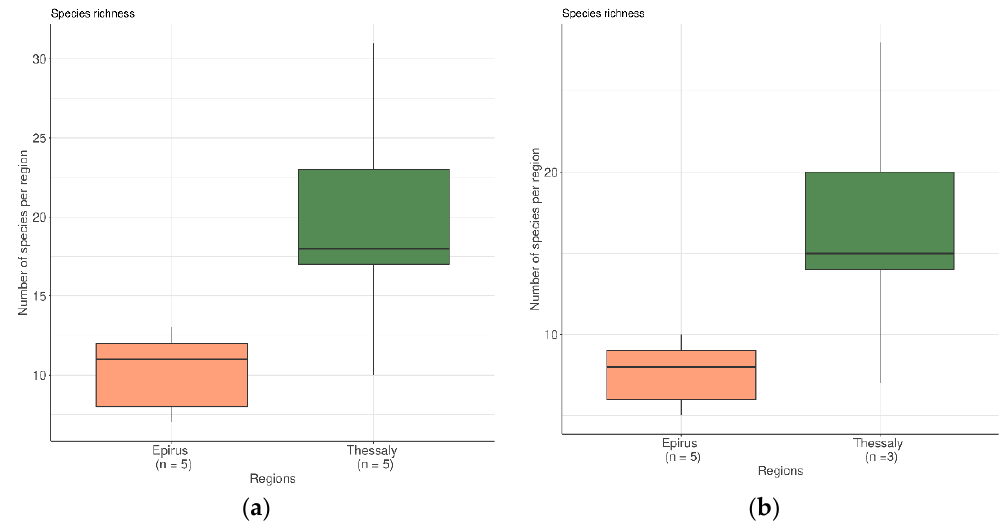
Figure 2. ( a ) Bar plot of the species richness for the two regions; all the species were included in the analysis ( p = 0.0472). ( b ) Bar plot of the species richness for the two regions after the three major species were removed from the analysis ( p = 0.0472).